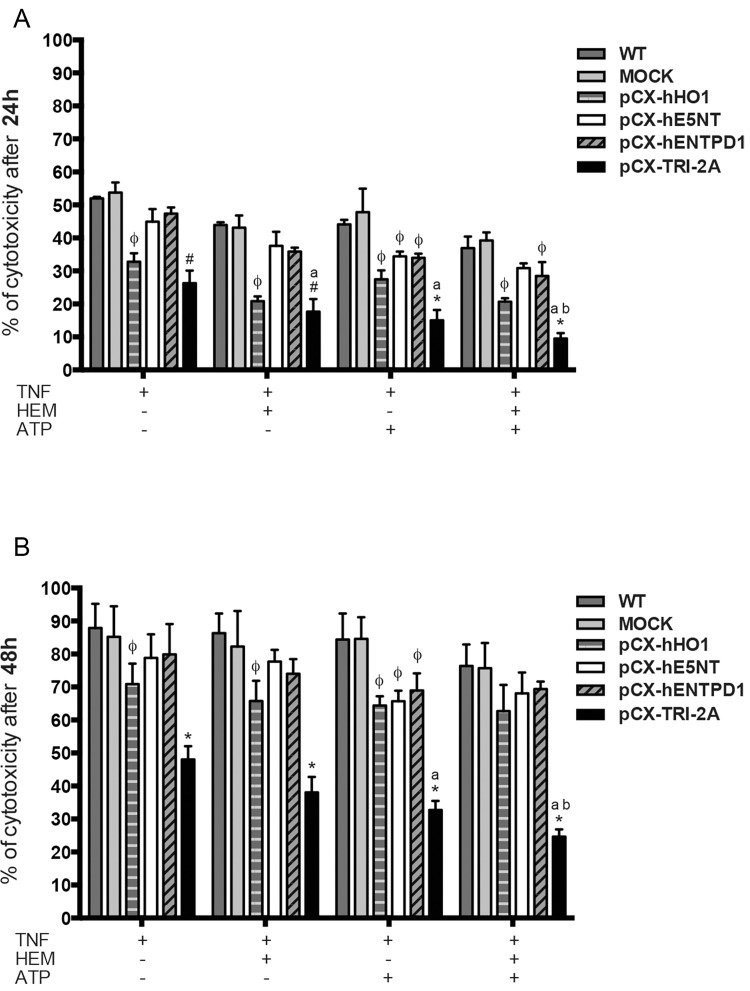
pCX-TRI-2A transfected cells are protected against TNF-α-induced cytotoxicity.WT cells and transfected cell lines were incubated with 50 ng/ml TNF-α for 24 h (A) and 48 h (B) alone or in combination with 20 μM hemin and/or 200 μM ATP. Cytotoxicity was assessed by lactate dehydrogenase (LDH) release and expressed as follows: relative cytotoxicity (%)  =  [(A e − A c) / (A b − A c)] × 100 (%), where ‘A e’ is the experimental absorbance, ‘A b’ is the absorbance of lysed controls and ‘A c’ is the absorbance of untreated controls. The data are expressed as mean ± SD of three independent experiments. [#] indicates significant difference between pCX-TRI-2A and all the other groups, except for pCX-hHO1, within the same treatment (ANOVA, p<0.05). [*] indicates significant difference between pCX-TRI-2A and all the other groups within the same treatment (ANOVA, p<0.05); [ϕ] indicates a significant difference between single gene-transfected cells and WT/mock within the same treatment (ANOVA, p<0.05); [a] indicates significant difference as compared to TNF-α treatment alone within the same cell type (ANOVA, p<0.05); [b] indicates a significant difference as compared to TNF-α + hemin treatment within the same cell type (ANOVA, p<0.05).